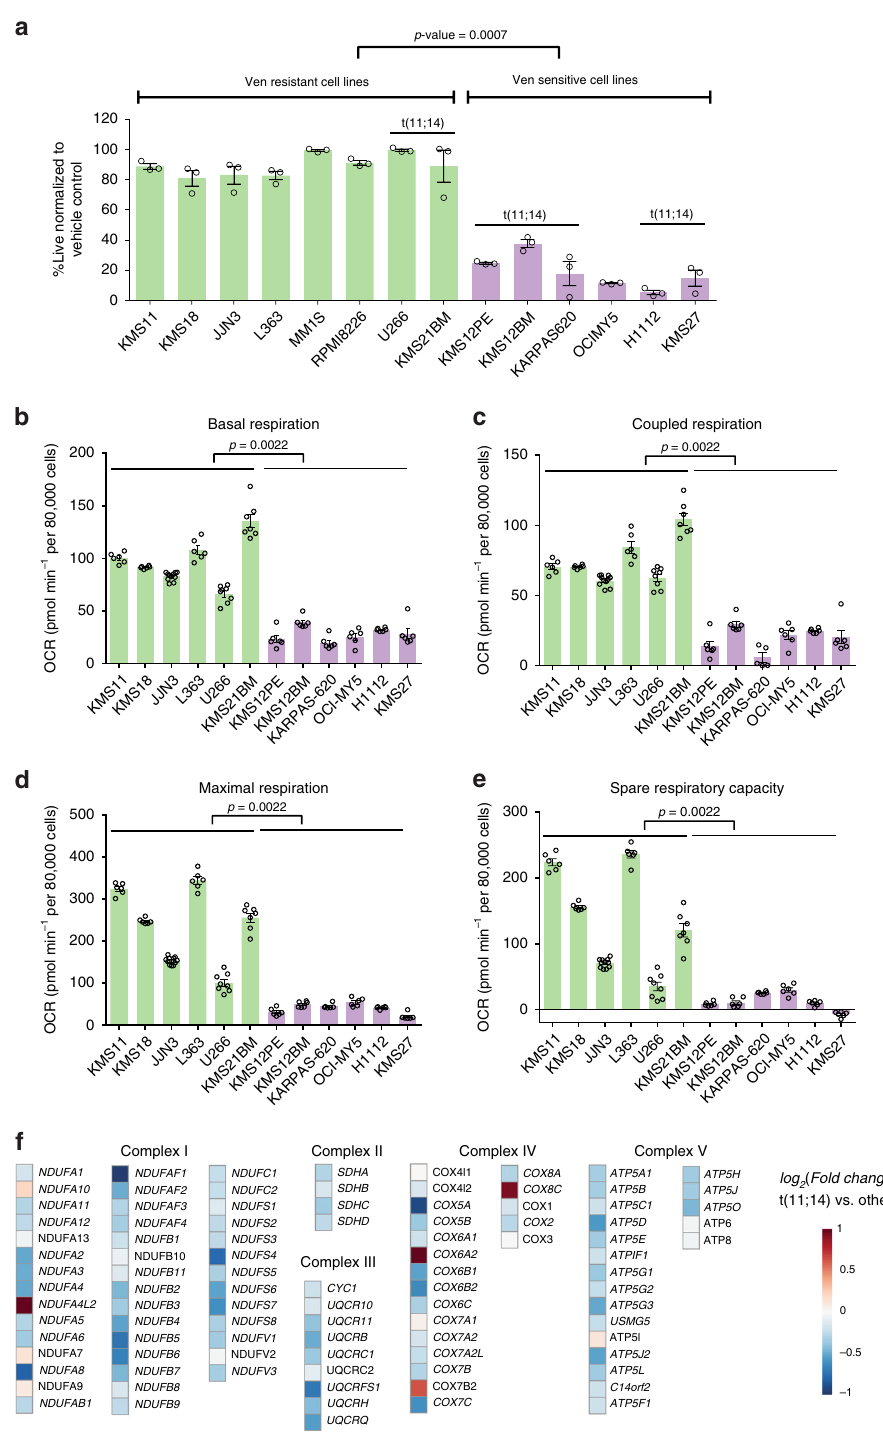
Fig. 1 Venetoclax-sensitive MM exhibits reduced cellular energetics in contrast to the venetoclax-resistant cells. a MM cell lines treated ±0.5 μ M venetoclax (Ven) for 24h were assessed for cell death by AnnexinV/4 ′ ,6-diamidino-2-phenylindole (DAPI) fl ow cytometric staining. Percent live normalized to vehicle control, with cell lines grouped by sensitivity. n = 3 independent experiments. Data are presented as mean values ± SEM. p value is calculated using a two-tailed Mann − Whitney test. b − d MM lines were evaluated for basal, coupled and maximal respiration in a mito stress assay using a Seahorse XF e 96 analyzer. n = 6 replicate Seahorse wells for each cell line except JJN3 ( n = 11), U266 ( n = 8) and KMS21BM ( n = 7). OCR displayed are normalized to live cell number. Data are presented as mean values ± SEM. Venetoclax-sensitive MM exhibited signi fi cantly lower basal, maximal and coupled OCR ( p values = 0.0022) determined after the addition of oligomycin, FCCP and antimycin/rotenone. p values are calculated using a two-tailed Mann − Whitney test. e Spare respiratory capacity in venetoclax-sensitive and -resistant cells was determined by subtracting basal OCR from maximal OCR. Data are presented as mean values ± SEM. Venetoclax-resistant lines have been shown in green and venetoclax-sensitive lines have been shown in purple bars in ( a − e ). f Heat map of electron transport chain-speci fi c gene expression in t(11;14) vs. non-t(11;14) patients derived from the CoMMpass trial RNAseq. Statistical signi fi cance (adjusted p value < 0.01) is highlighted for gene names in bold-italic font . Source data are provided as a source data fi